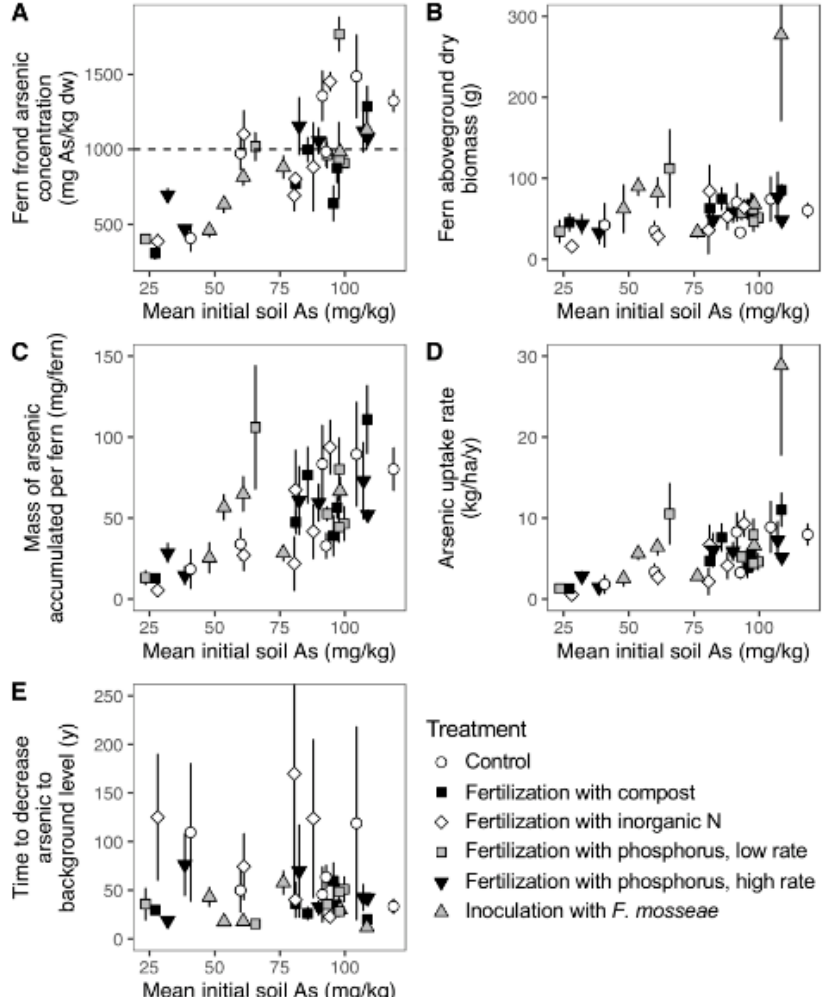
Figure 2. Mean ( A ) fern arsenic concentrations, ( B ) fern aboveground dry biomass, ( C ) fern accumulated arsenic mass, ( D ) arsenic uptake rates, and ( E ) remediation times at final harvest, 58 weeks after fern transplanting in arsenic-contaminated soils. n = 4. Dotted line in panel A indicates hyperaccumulation threshold. Symbols represent mean values per plot, and error bars represent standard error of the mean. See Figure S1 for mean arsenic concentrations and biomass per treatment.